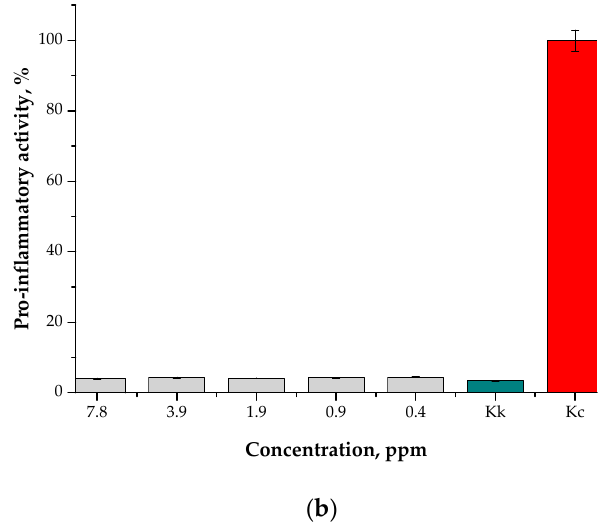
Figure 16. Results of the analysis of the pro-inflammatory activity of the particle suspensions obtained in the water reaction medium ( a ) and the oil/water reaction medium ( b ).